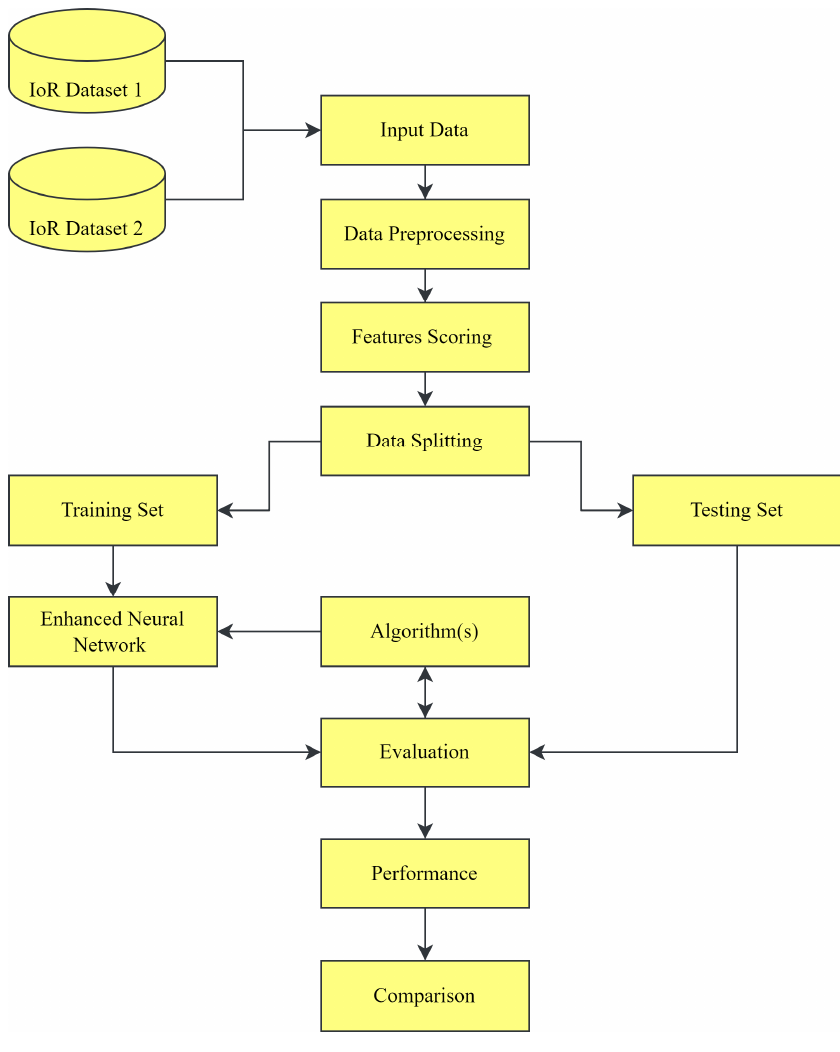
Figure 3. Proposed Workflow.